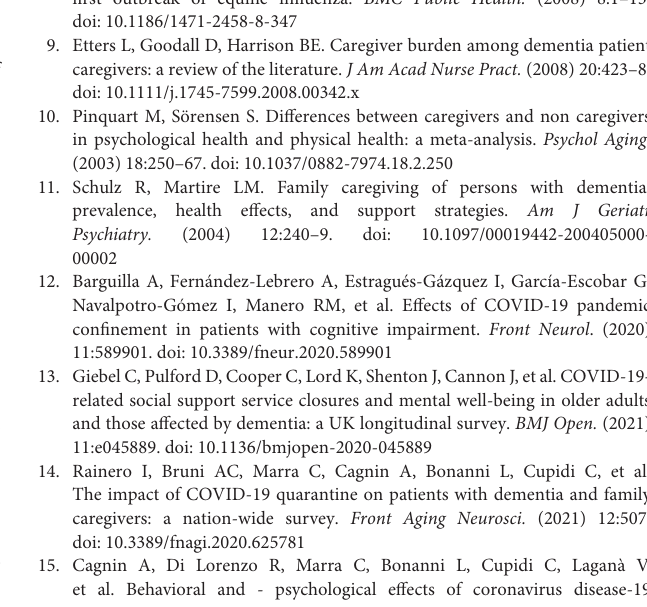
Supplementary Figure 1 | Correlation matrices within the caregiver’ group (left) and the non-caregivers’ group (controls; right) between the components of each standardized questionnaire administered. White spaces indicate that there is no correlation. Supplementary Figure 2 | Correlation between the sleep quality, depression and anxiety’s scores predicted by the model vs. the scores really obtained at T2 ( p <